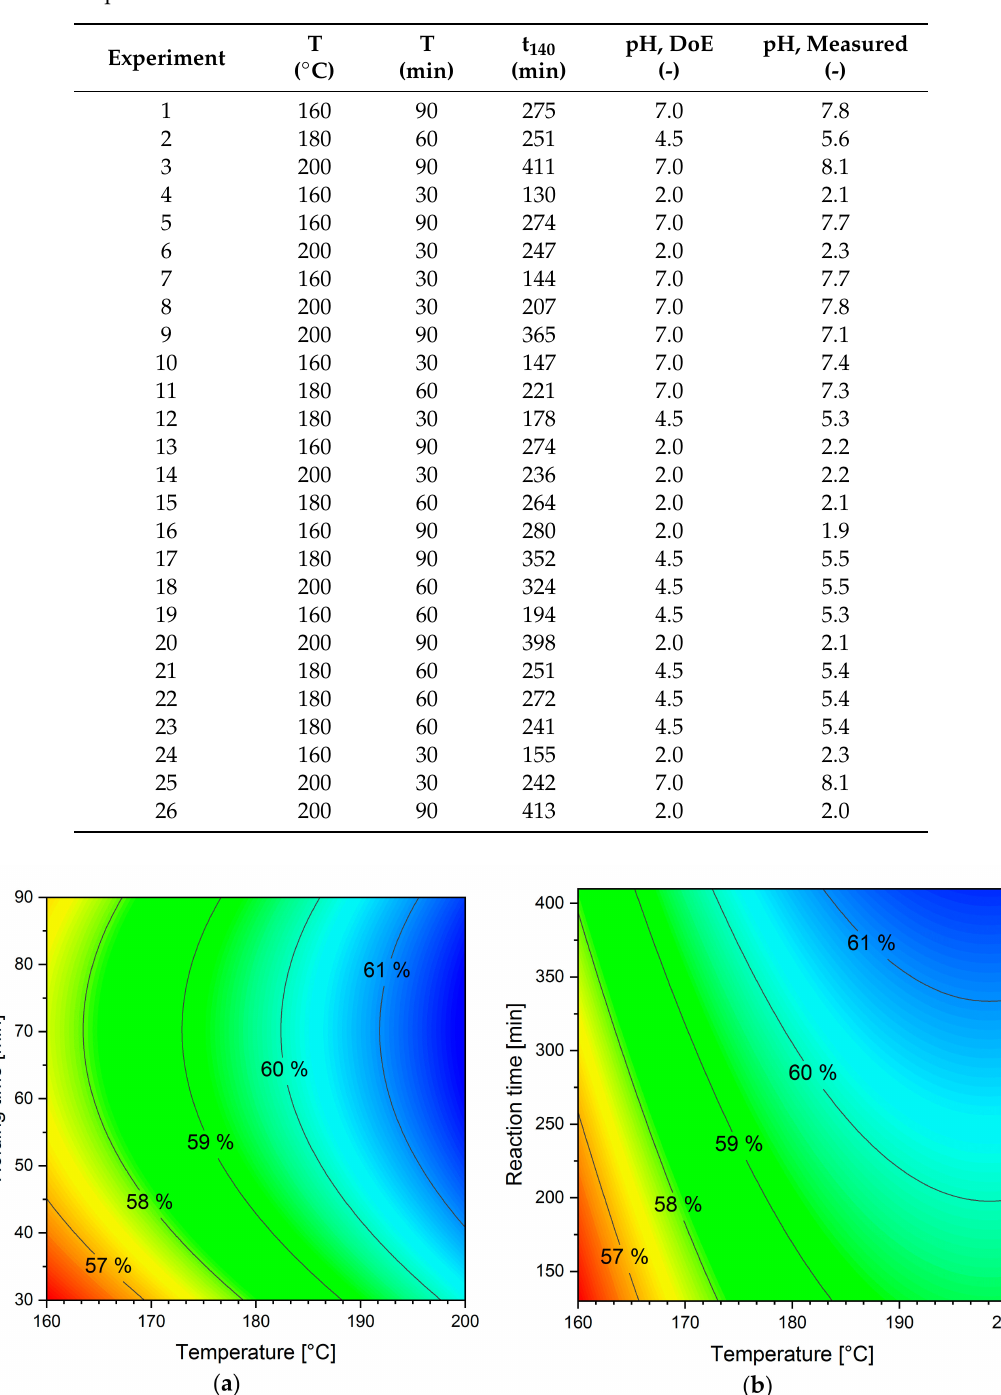
Table A1. Experimental design (temperature, holding time, and pH) as well as reaction time and measured pH.